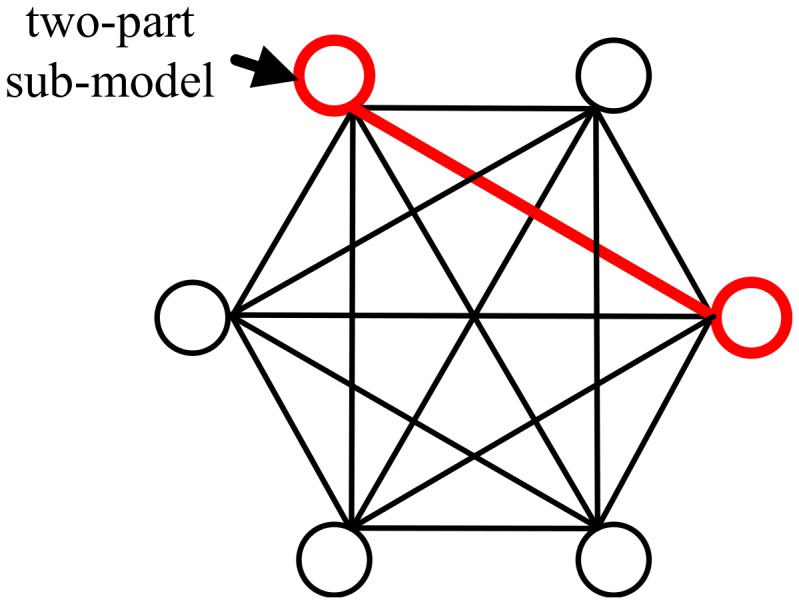
Two-part sub-model.